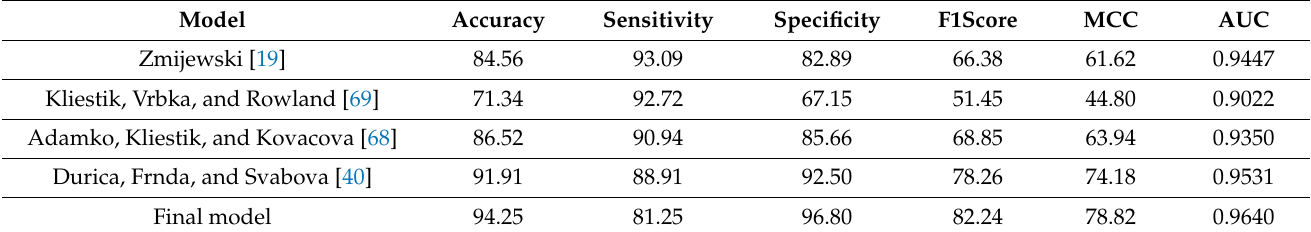
Table 12. Performance